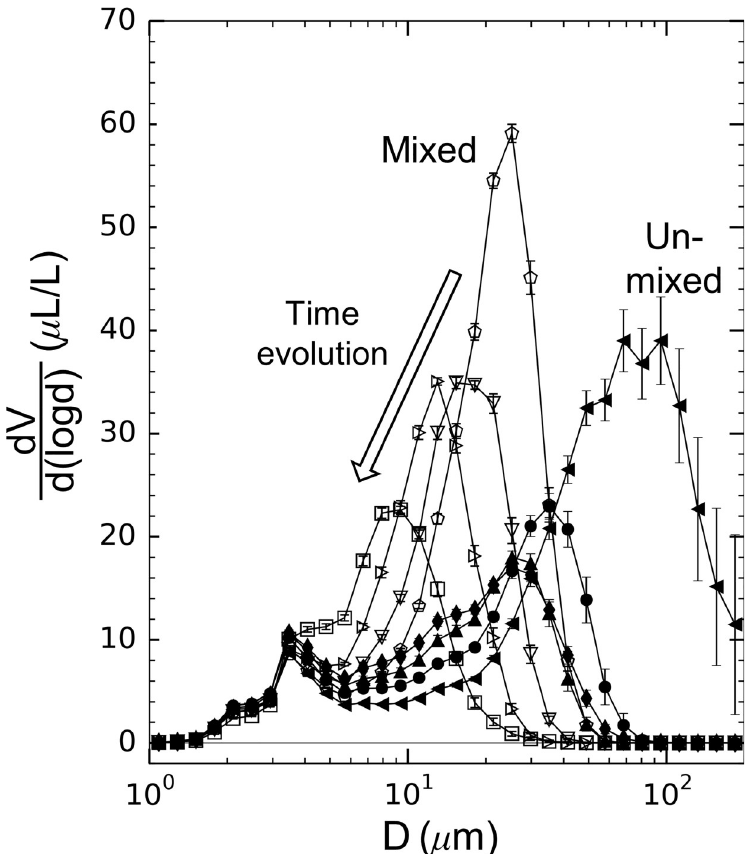
Fig 4. Particle size spectra measured in the aggregation tank for all eight experimental runs. Symbols consistent with Table 3. Error bars represent one standard